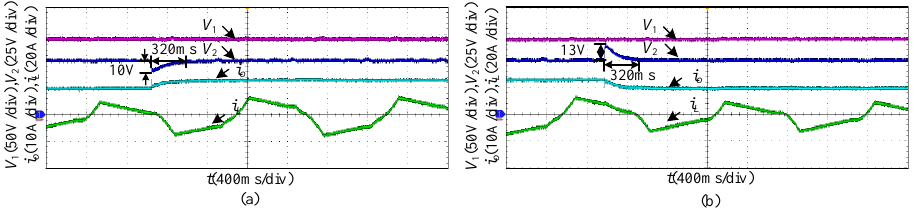
Figure 10. Transient waveform of the traditional voltage closed-loop control strategy when the load steps change: ( a ) the load steps from 5 to 3.79 Ω , ( b ) the load steps from 3.79 to 5 Ω . When the input and output state and load of the system remained constant, Figure 11 showed the experimental waveforms of the input voltage, output voltage, output current, and inductor current of the DAB converter based on the MUOC strategy under the